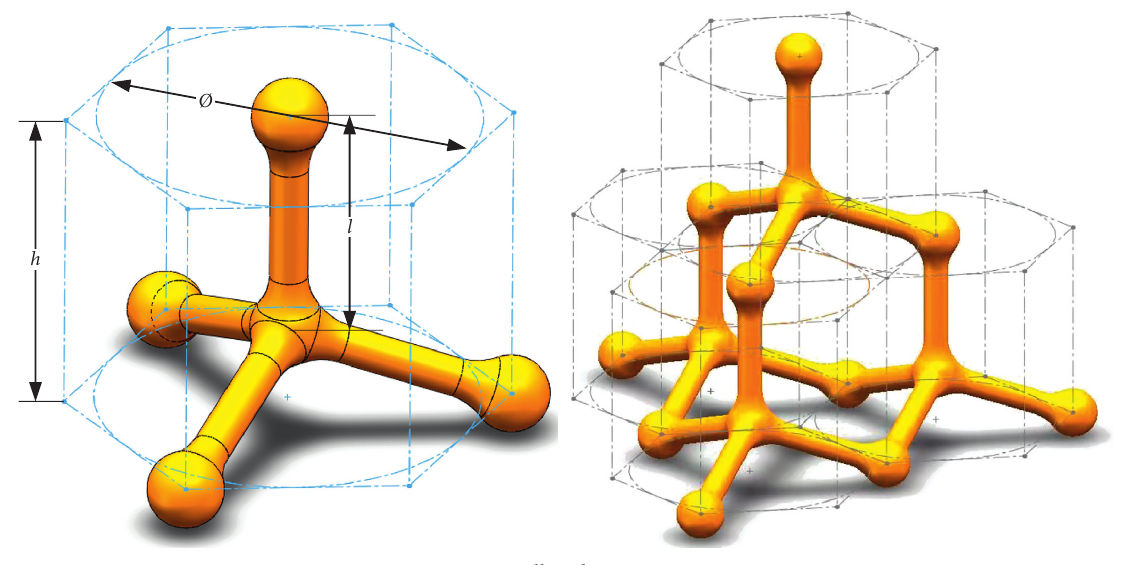
Figure 3: HP cell and its